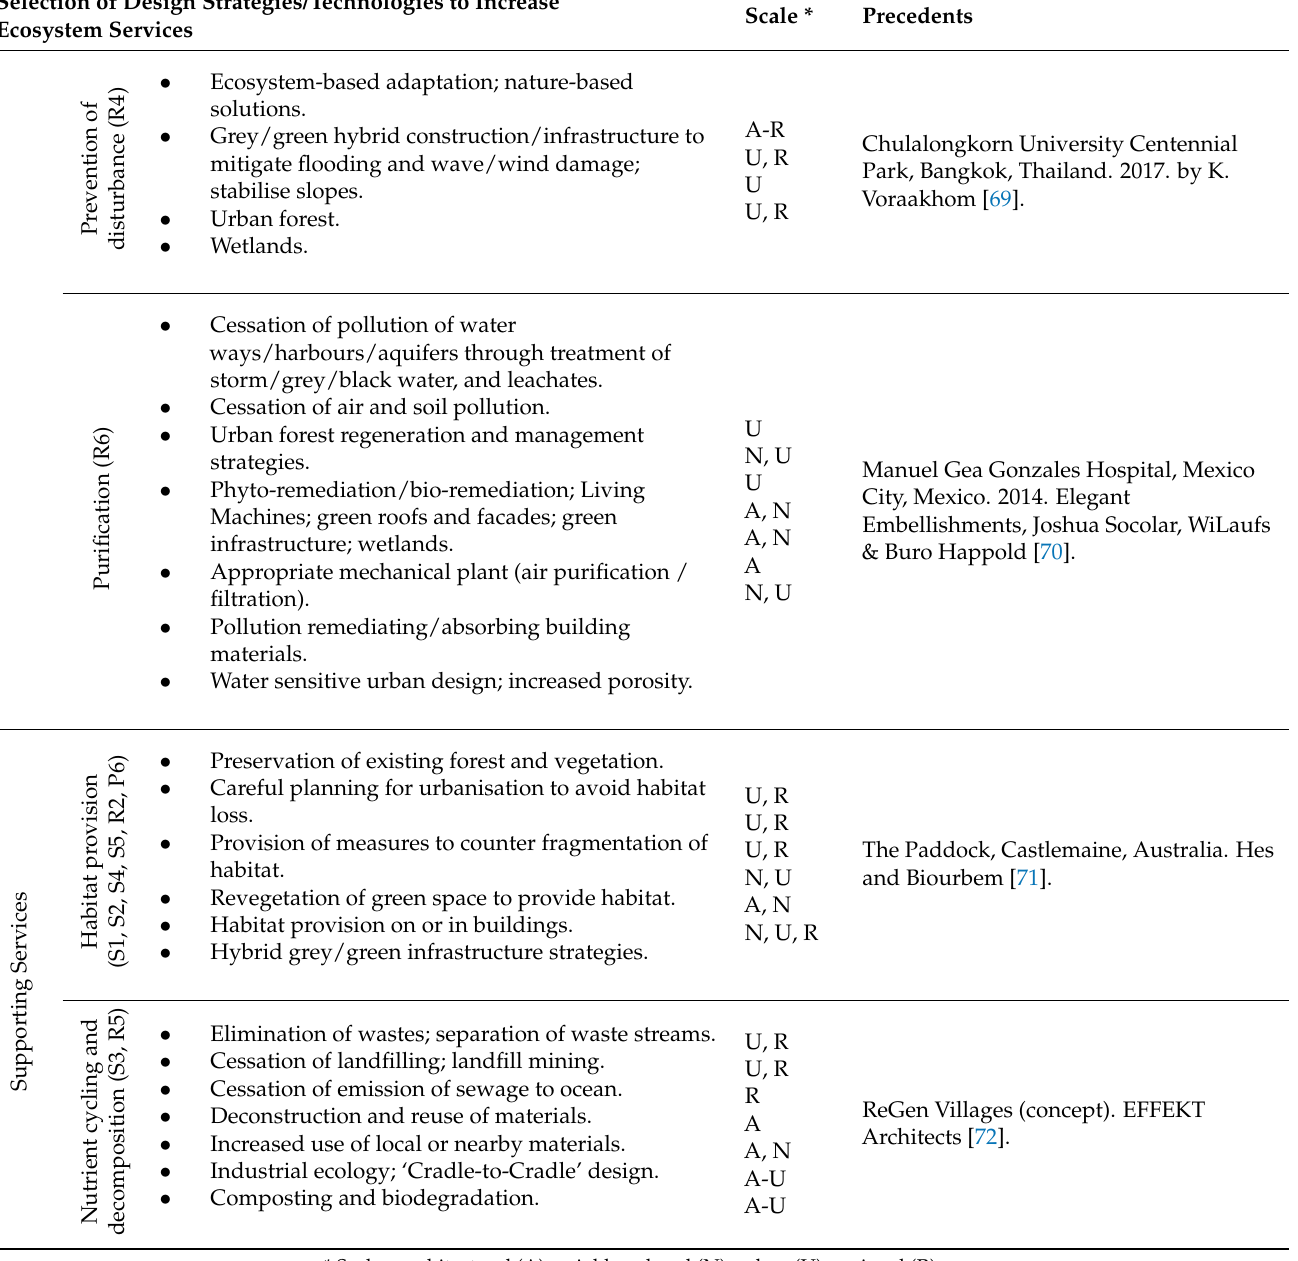
Selection of Design Strategies/Technologies to Increase Ecosystem